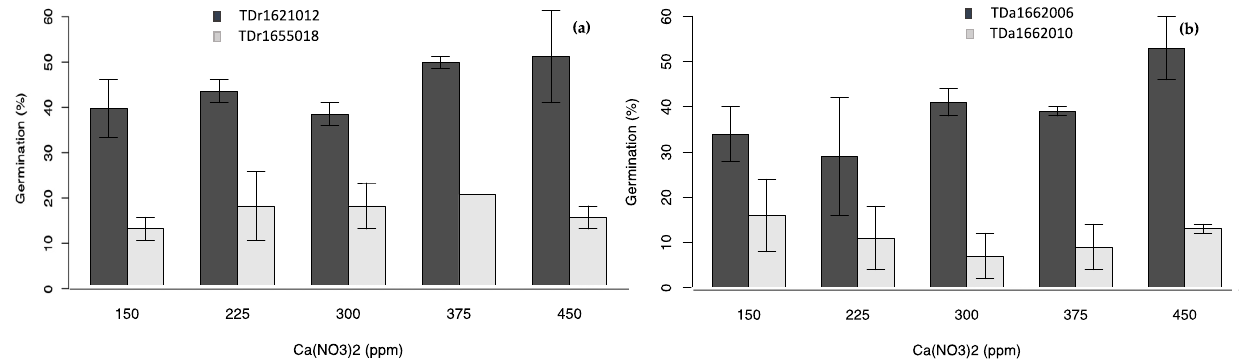
Figure 3. Effects of calcium nitrate on pollen germination of genotypes of ( a ) D. rotundata , ( b ) D. alata.